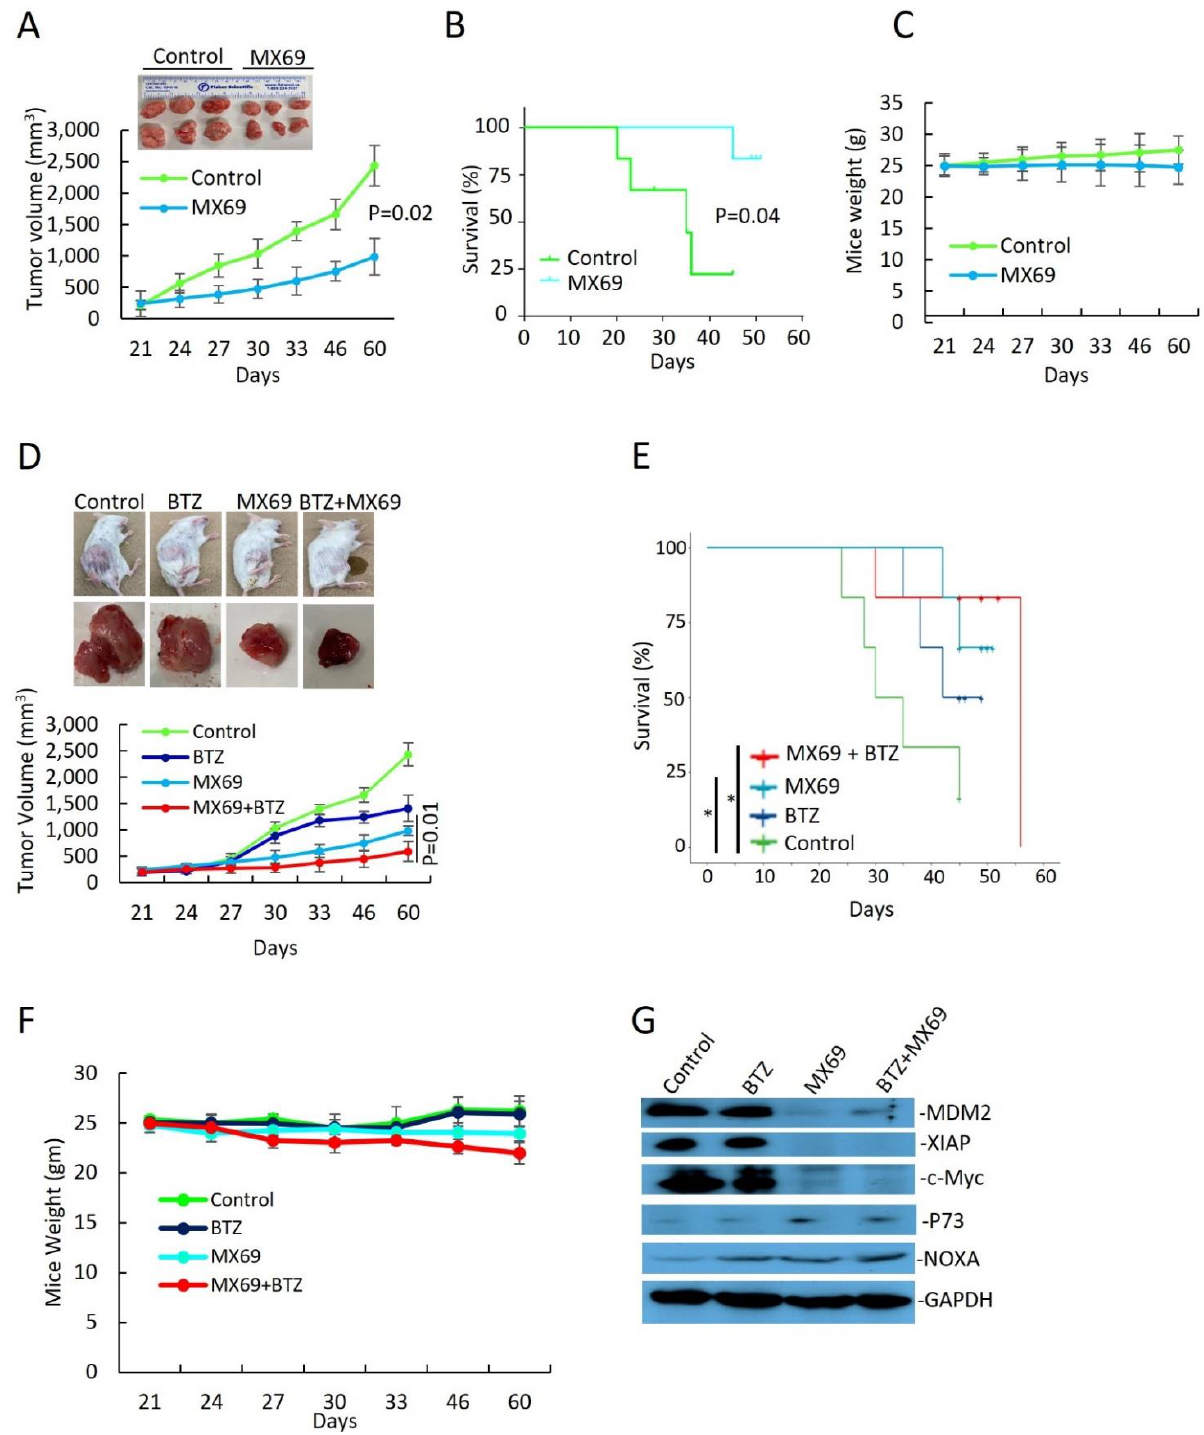
Figure 7. MX69 inhibits MM growth and prolongs survival in xenograft MM model. SCID mice ( n = 6 per group) were inoculated s.c. with 1 × 10 7 8226R5 cells in RPMI medium along with Matrigel matrix. Tumor-bearing mice were randomly assigned into two cohorts receiving daily i.p. injection of MX69 twice a week with 0.5 mg/kg BTZ alone, three times a week with 50 mg/kg MX69 alone or combined with 0.5 mg/kg BTZ, or an equal volume of vehicle for 21 days. ( A ) Tumor volume in xenograft mice receiving drug vehicle or MX69 at different time points, as indicated. (Top) Representative images of engrafted MM tumors at mice death. ( B ) Kaplan – Meier curve indicating overall survival of xenograft mice receiving drug vehicle or MX69, as indicated. Survival analysis was performed using the Kaplan – Meier product limit method. Overall survival was calculated from the first day of tumor cell injection until death or occurrence of an event. ( C ) Body weight of xenograft